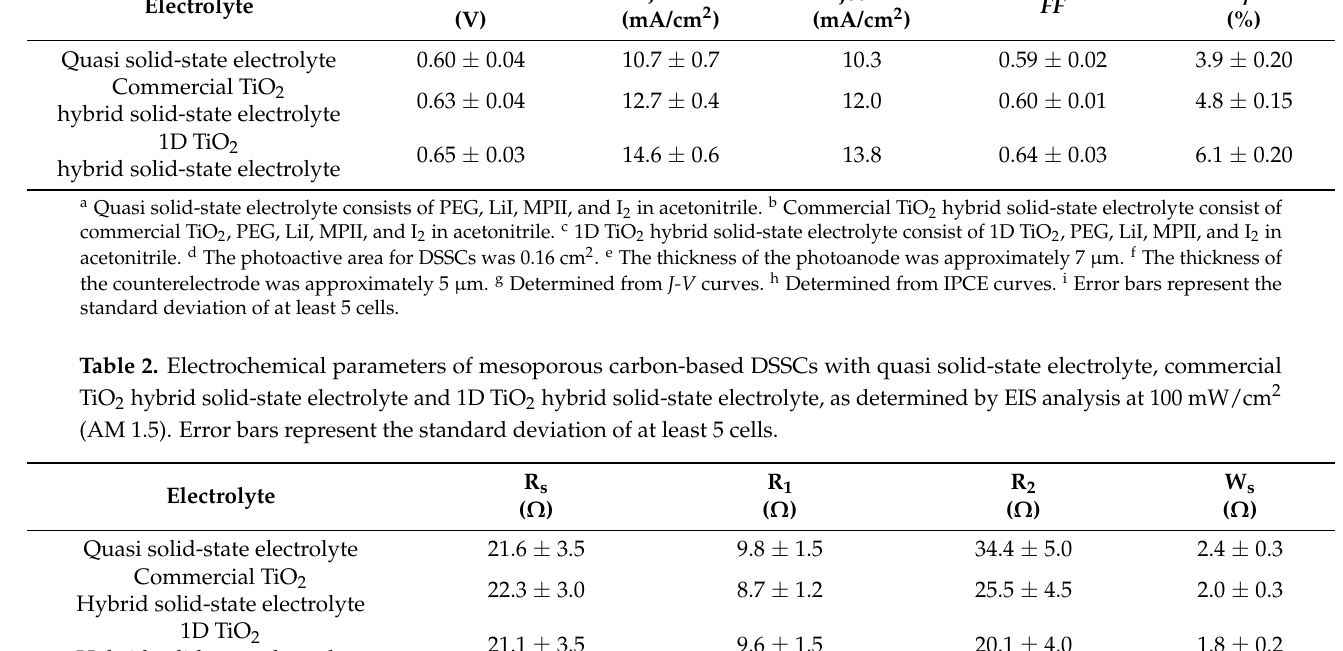
Table 1. Photovoltaic properties of mesoporous carbon-based dye-sensitized solar cells (DSSCs) with quasi solid-state electrolyte, commercial TiO 2 hybrid solid-state electrolyte, and 1D TiO 2 hybrid solid-state electrolyte at 100 mW/cm 2 (AM 1.5) a, b, c, d, e, f, g, h, i . Voc Electrolyte Quasi solid-state electrolyte 0.60 ± 0.04 Commercial TiO 2 0.63 ± 0.04 hybrid solid-state electrolyte hybrid solid-state electrolyte